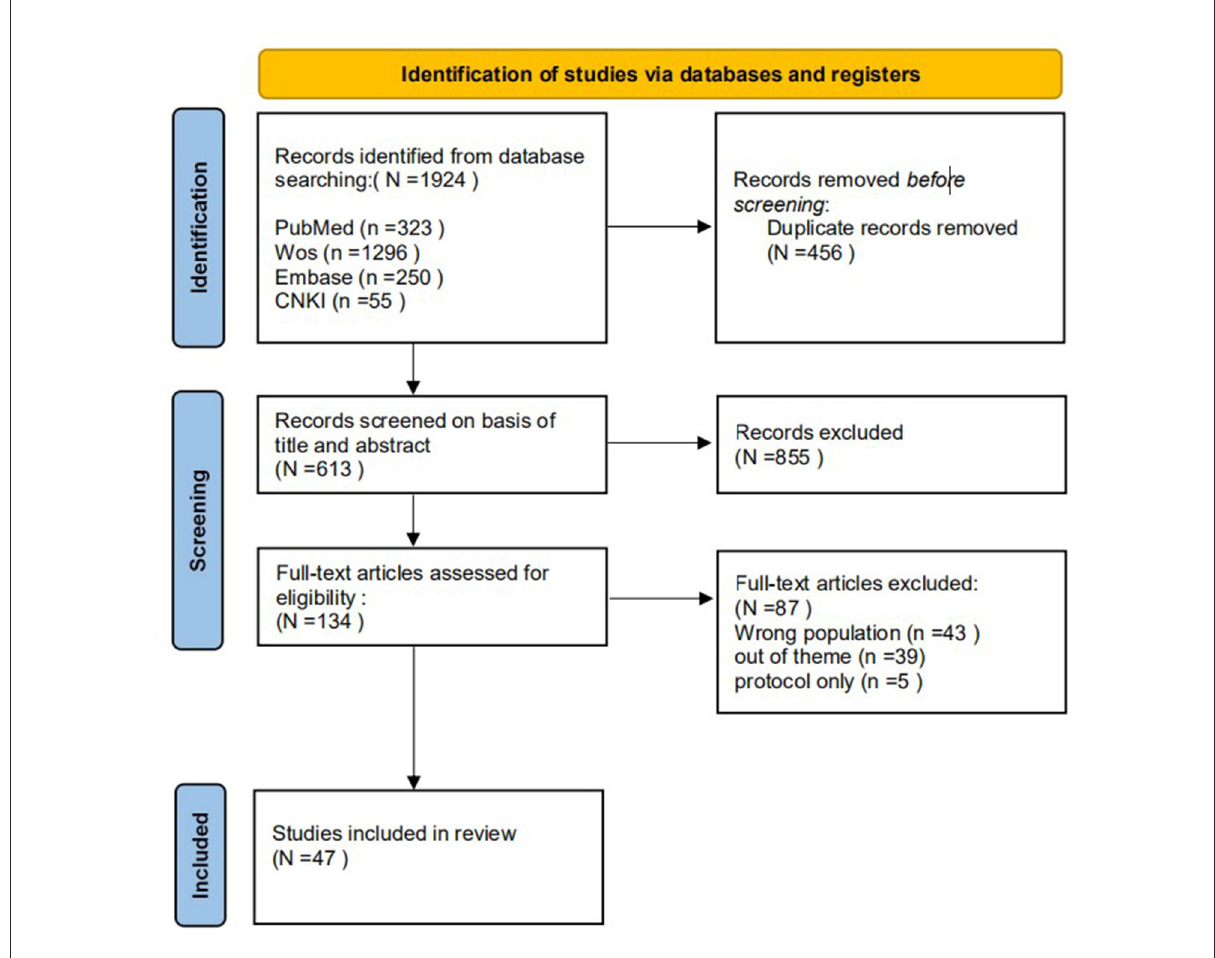
FIGURE1 Flowchart of the literature screening